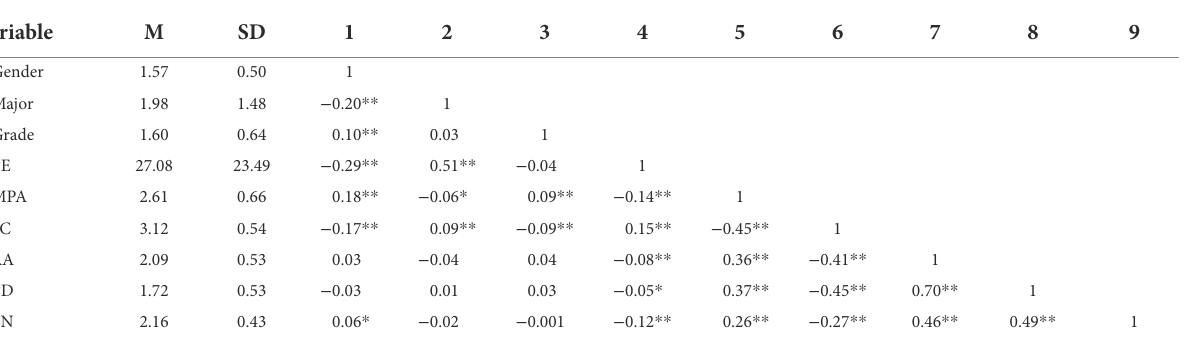
PE, physical exercise; MPA, mobile phone addiction; SC, self-control; RA, Rumination; PD, psychological distress.